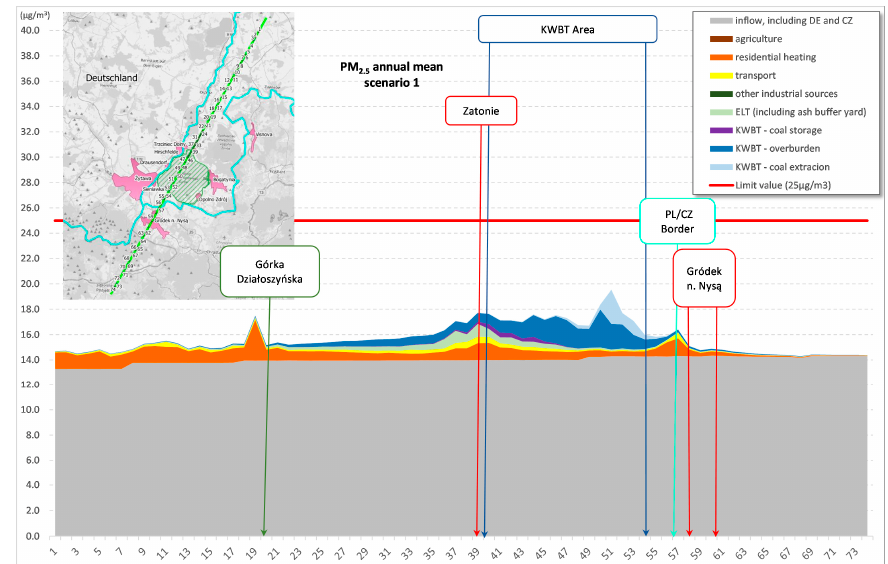
Figure 22. Profile of annual mean concentrations of PM 2.5 between Dzia ł oszyn and Hrádek nad Nisou, considering the shares of individual source groups in 2018 (source : own study).